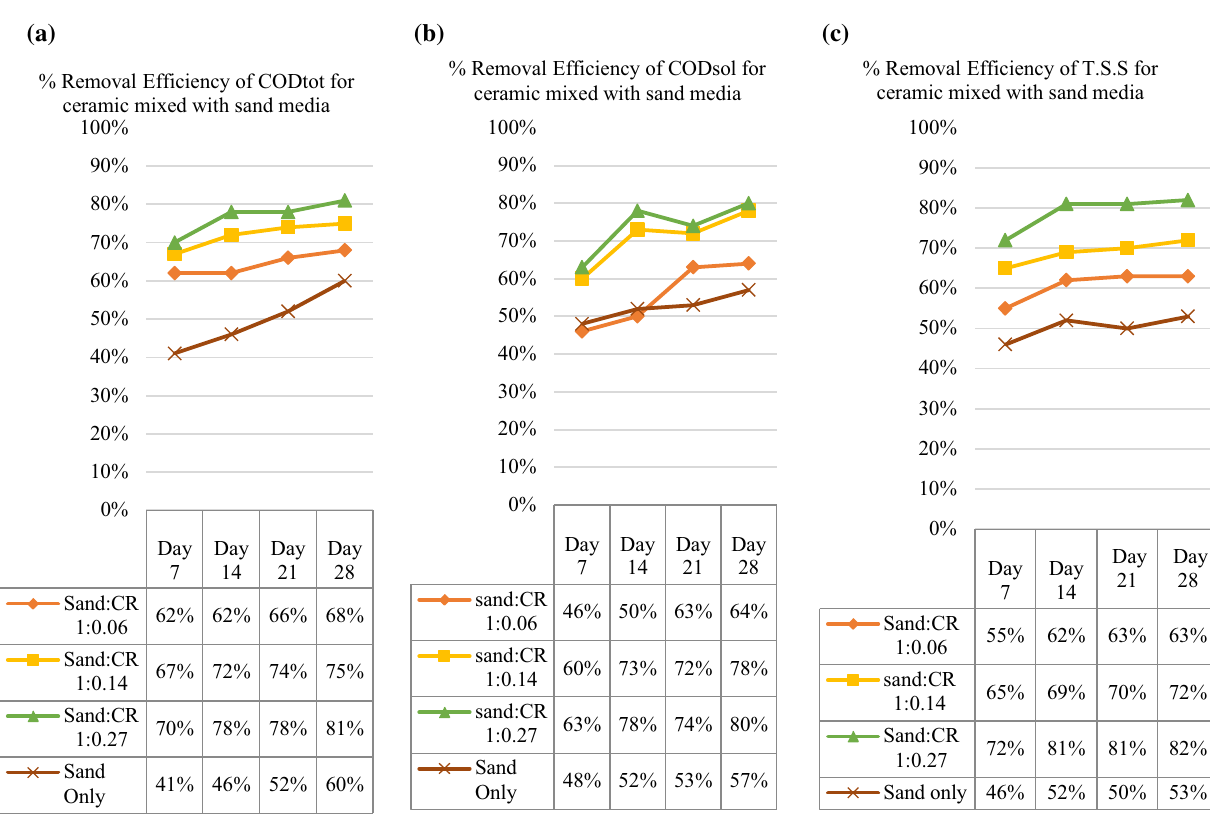
Fig. 15 Results obtained from run (4), a %R.E. of COD tot for sand and ceramic cylinder mixture, b %R.E. of COD sol for sand and ceramic cylin- der mixture, c %R.E. of TSS for sand and ceramic cylinder